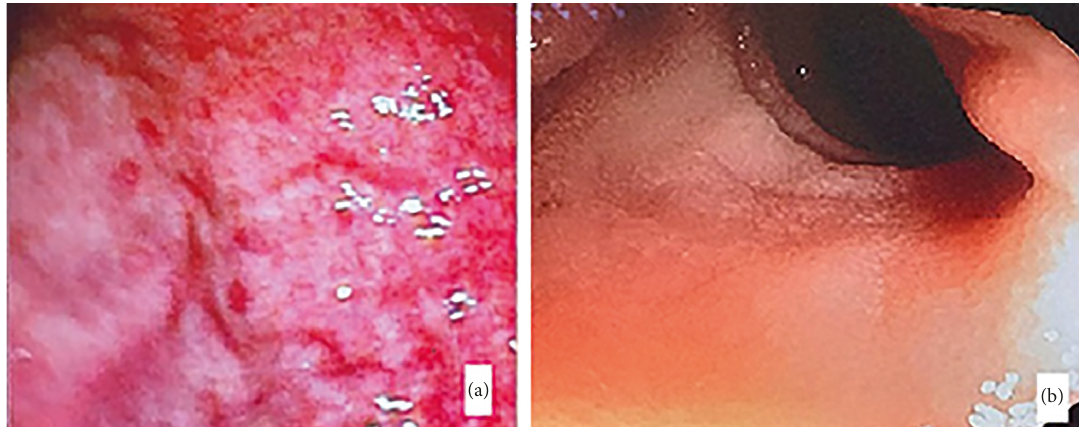
Figure 1: (a) Endoscopic image showing the evidence of hemorrhagic gastritis. (b) Colonoscopic view showing the presence of bowel wall edema.